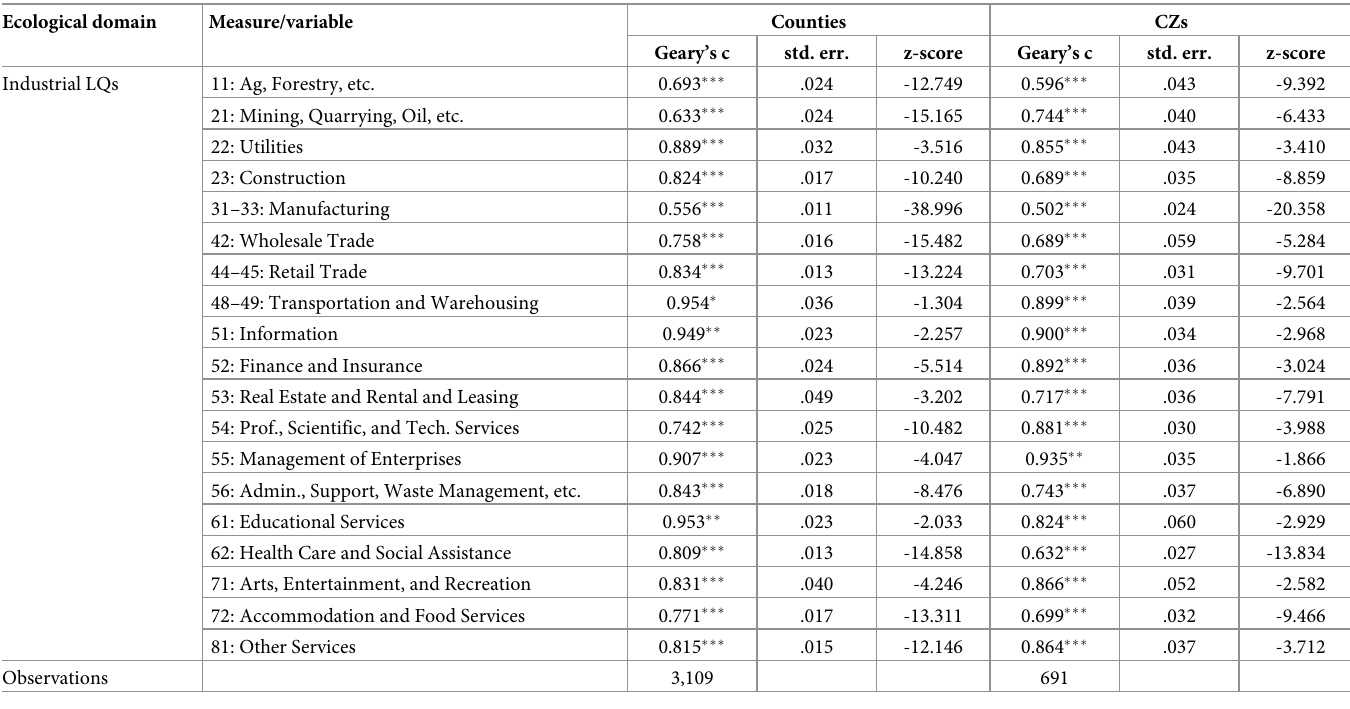
Table 5. Global Geary’s c for industrial LQs (Counties versus CZs). Ecological domain